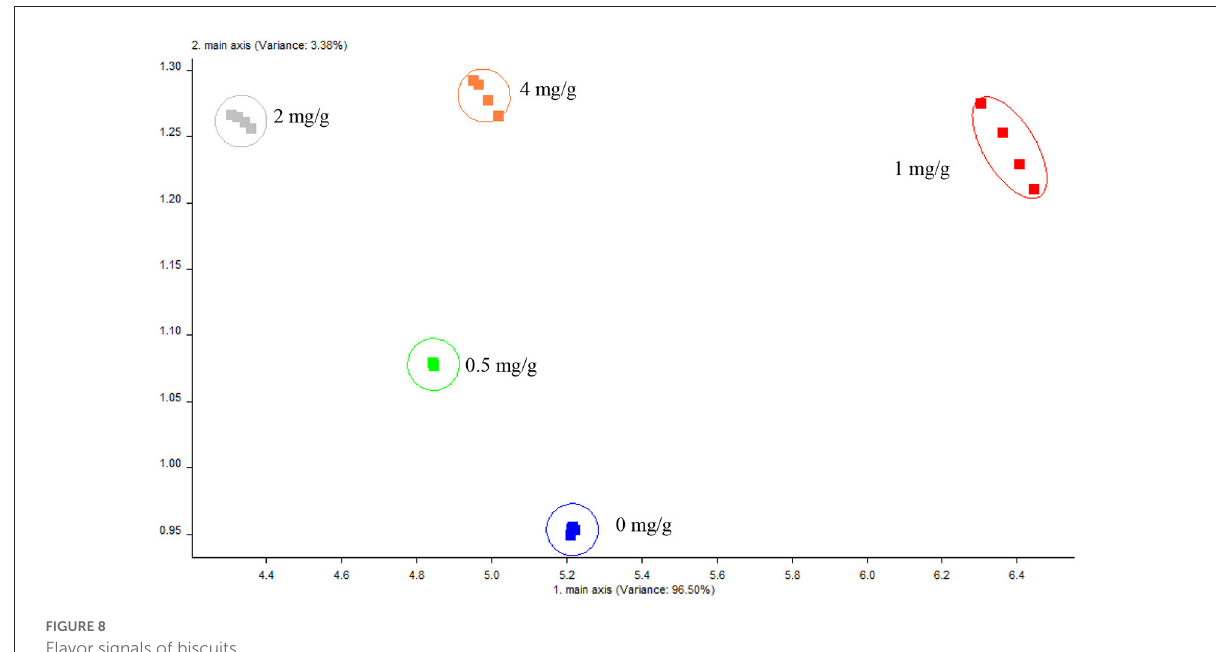
FIGURE8 Flavor signals of biscuits.